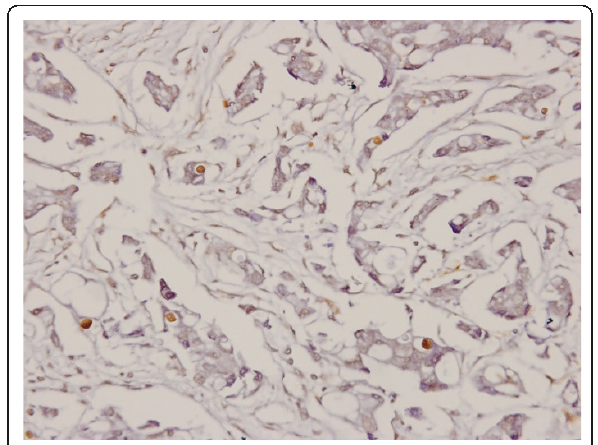
Figure 5 Representative positive apoptotic tumor cells in IDC by TUNEL detection . Original magnification for this figure: ×400.